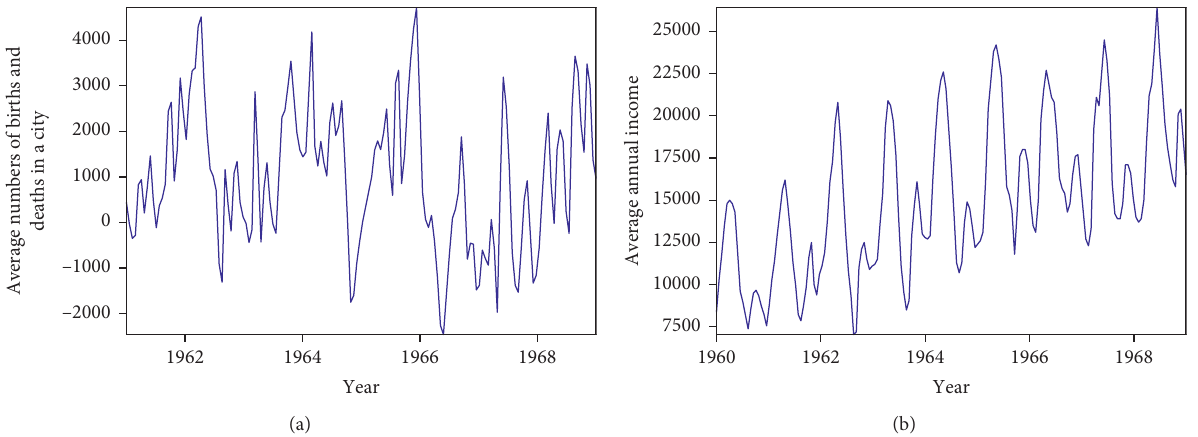
Figure 1: Time-series schematic diagram. The evolution of the stationary time series is usually around a fixed interval, while the evolution interval of the nonstationary time series has apparent variation. (a) Stationary time series. (b) Nonstationary time